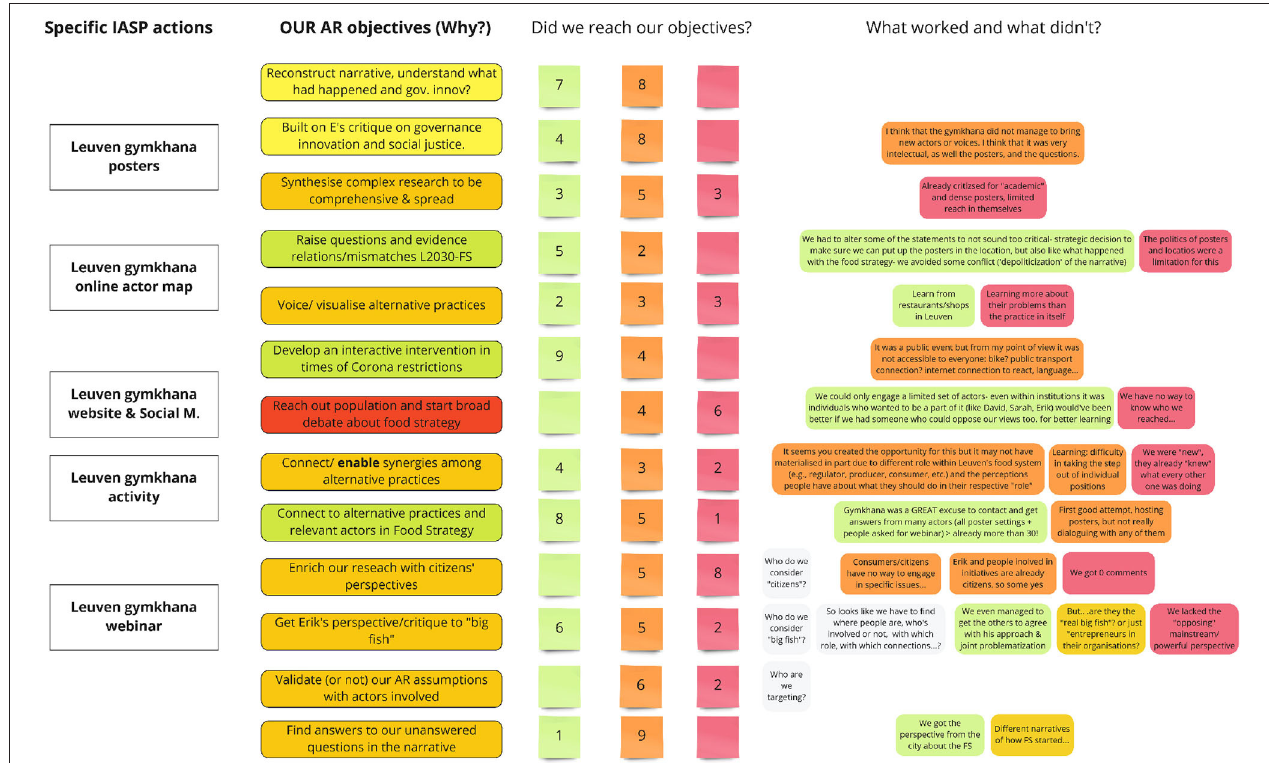
FIGURE 5 | Screenshot from the IMSDP Miro board understanding the AR process and evaluating the IASP work to inspire further IMSDP